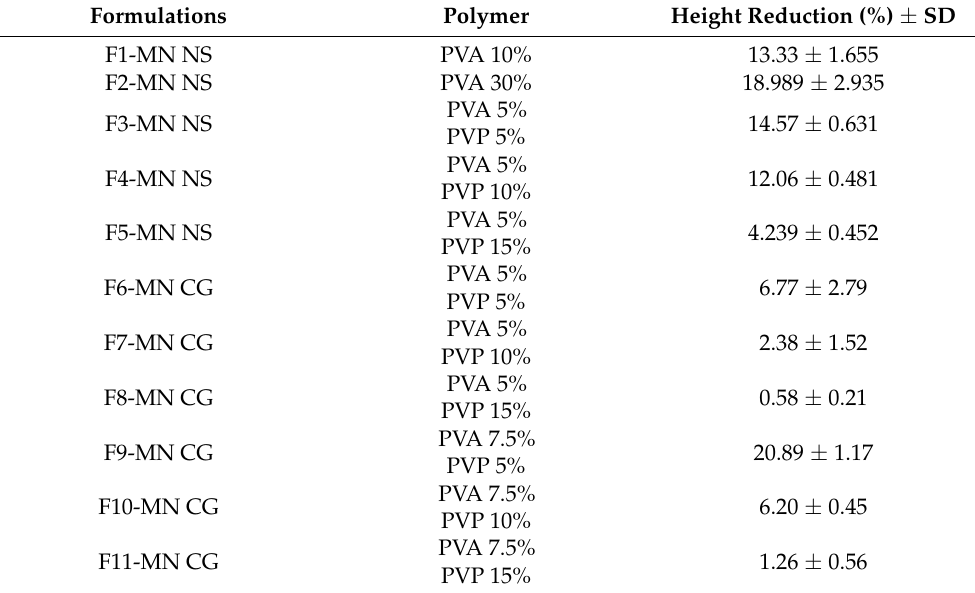
Table 6. Height Reduction in DMN Containing Nanosuspension and Co-grinded Ketoprofen (n = 3, mean ± SD).